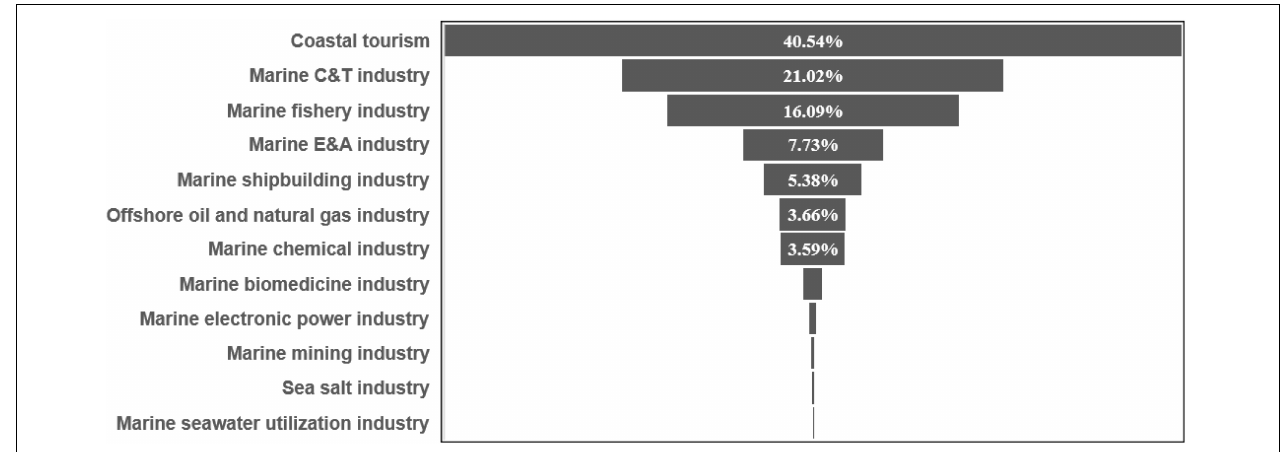
FIGURE 9 | Composition of marine economy growth in 2015. C and T refers to communication and transportation, while E and A means engineering and architecture.